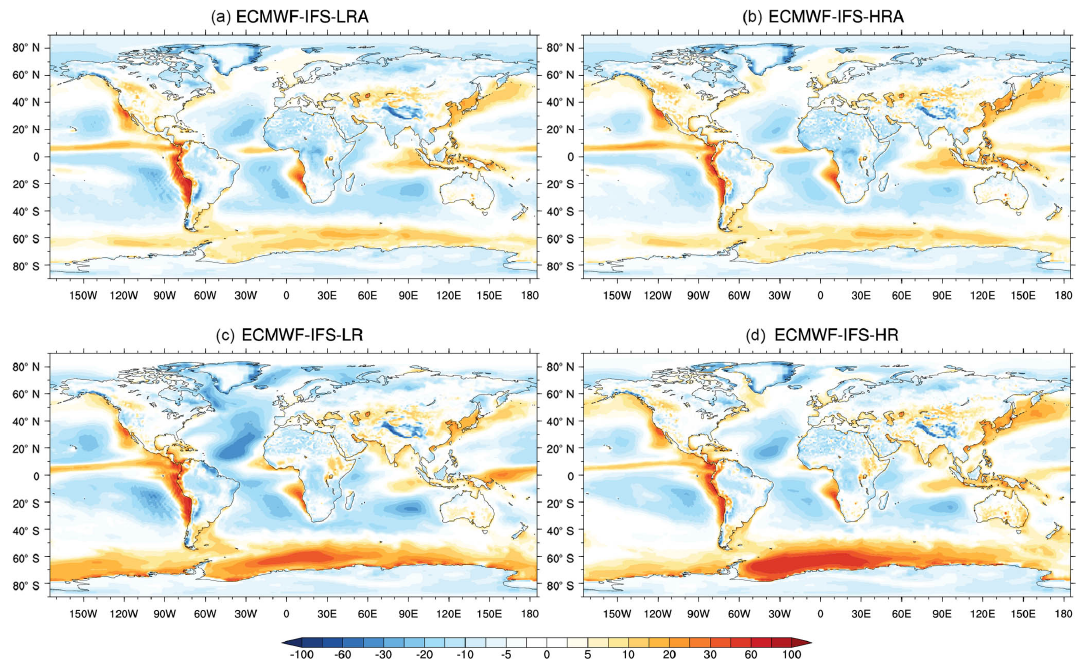
Figure 9. Annual mean bias in net surface short-wave radiation in (a–b) highresSST-present and (c–d) hist-1950 relative to data from CERES-EBAF surface fluxes edition 4.0 (Kato et al.,